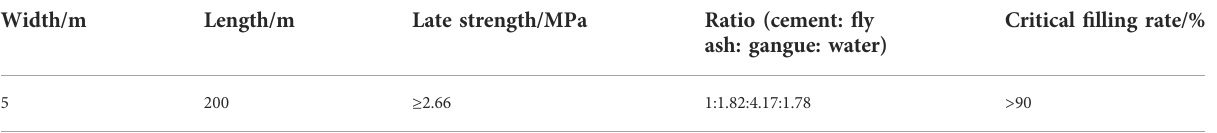
TABLE 6 Key parameters of the branch roadway and back fi ll body in the Dingjiaqu coal mine.